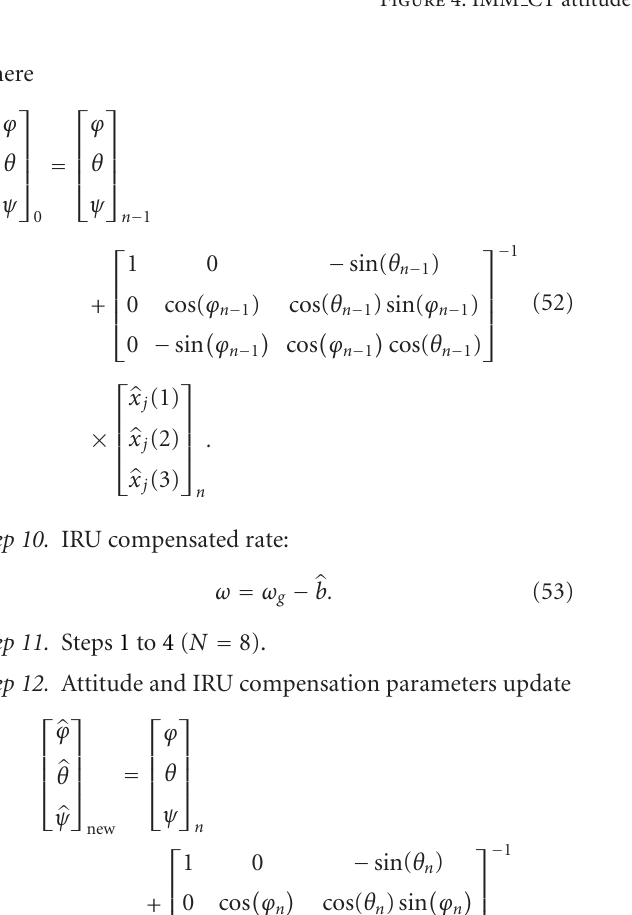
Figure 4: IMM CT attitude estimator